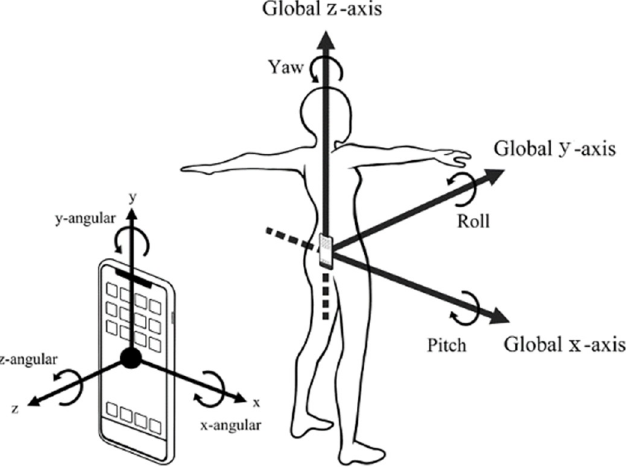
Fig 3. Axis settings in the device coordinate system and the global coordinate